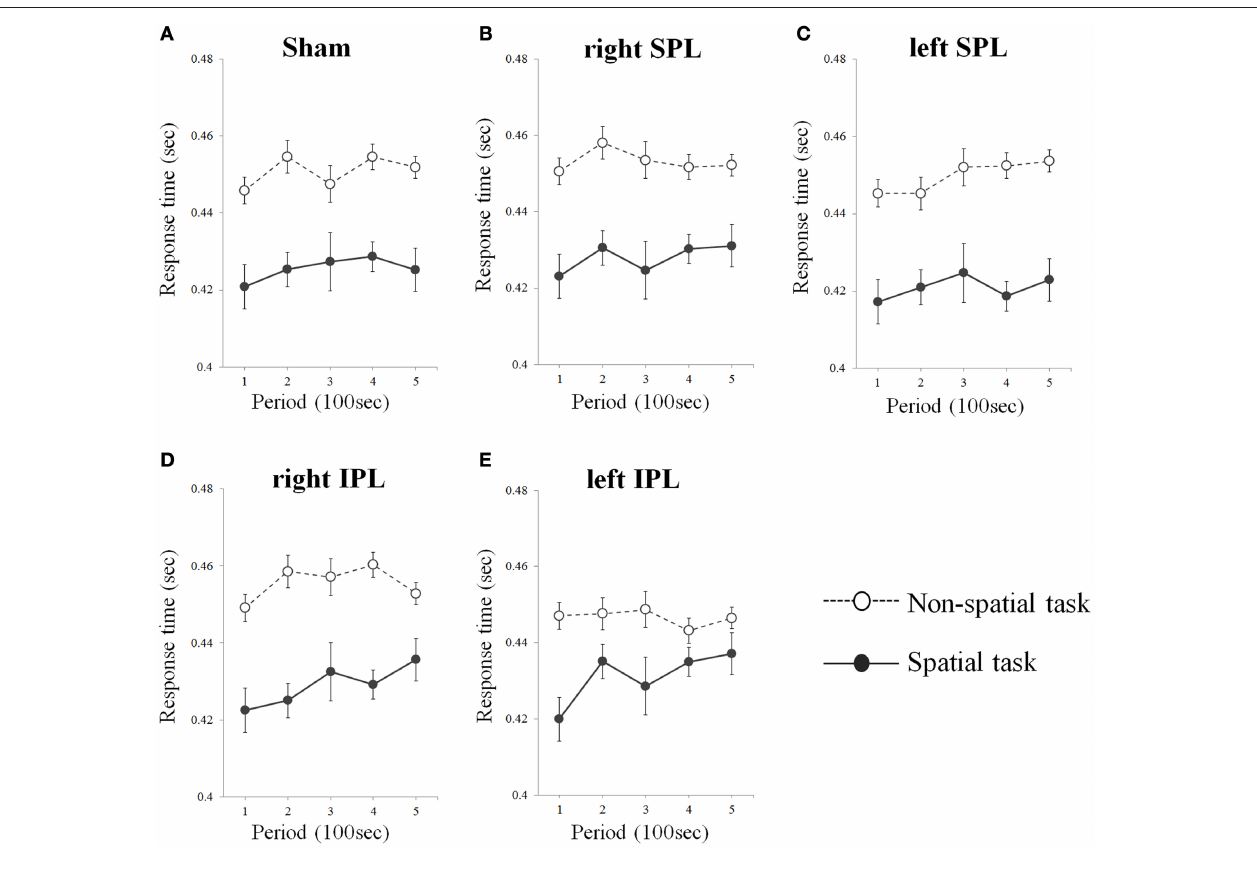
FIGURE 3 | (A–E) Response time over time whilst performing two types of task. Response times were averaged at each period which consists of 20 tests (Error bars indicates SEM). As sham condition, the same clicking sound